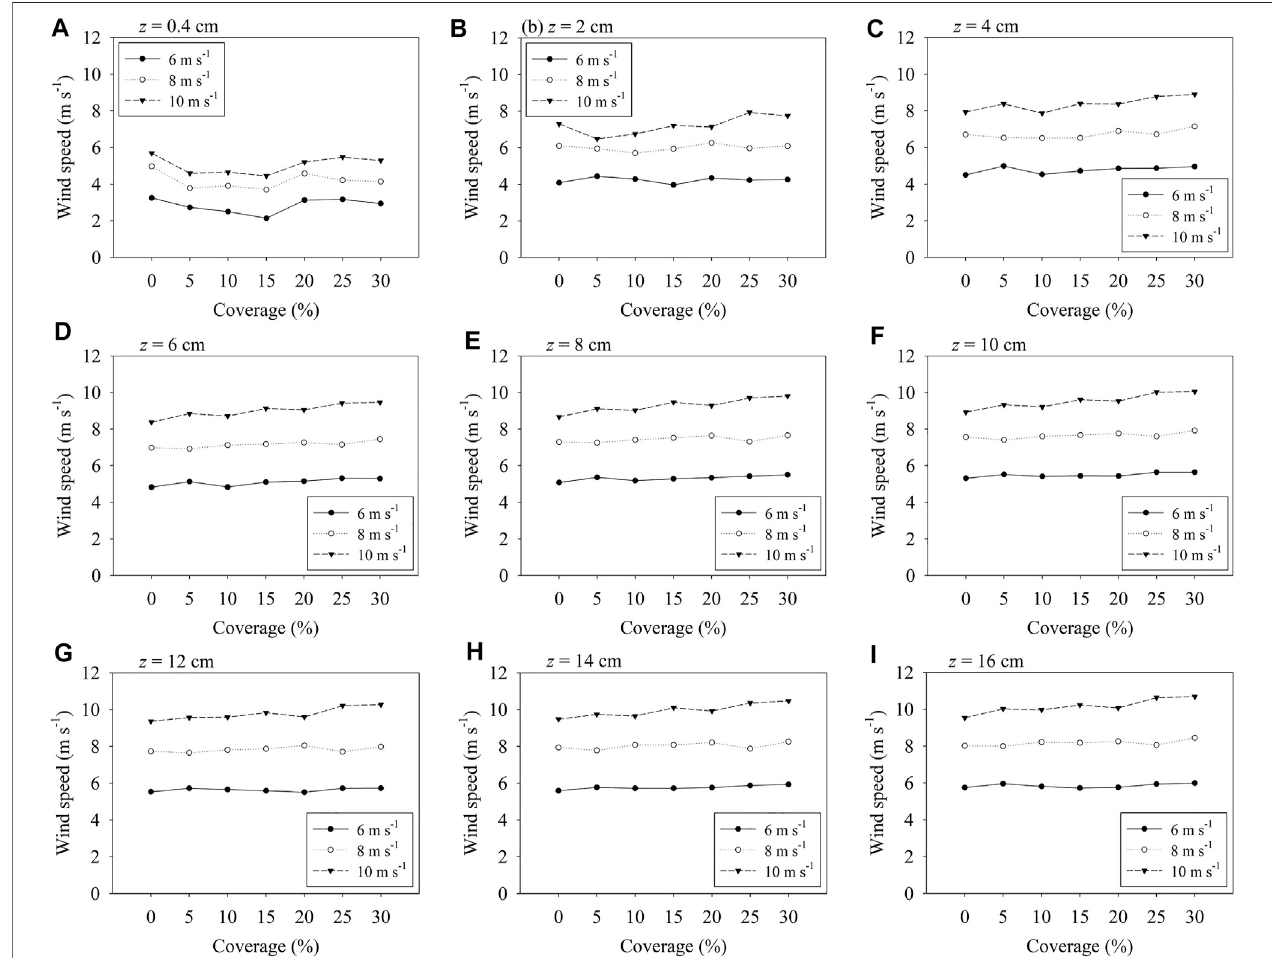
FIGURE 8 | Variations in wind speed at different gravel coverages under each wind speed at heights of 0.4 – 16 cm.